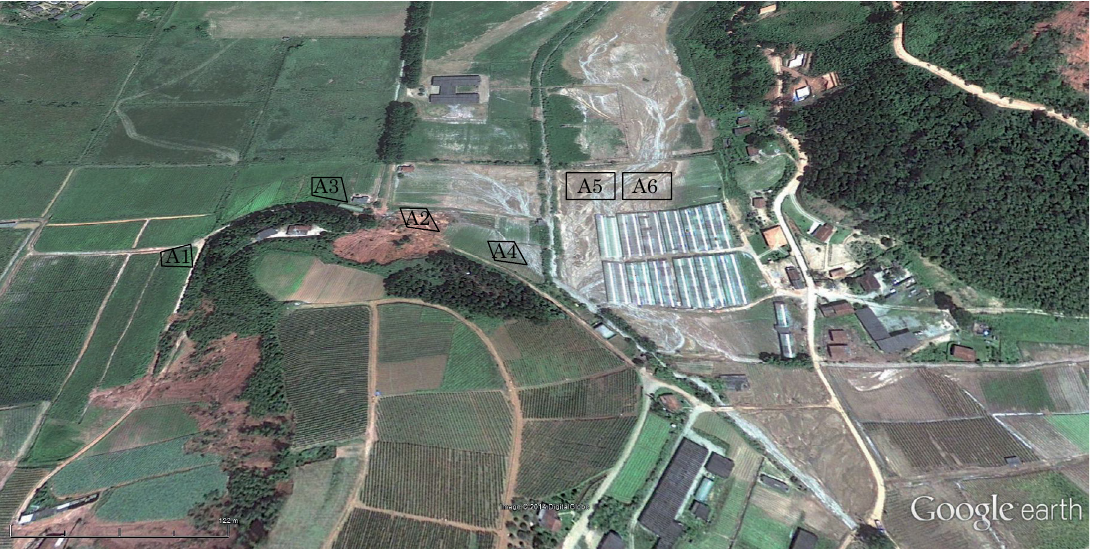
Figura 1. Localização das áreas de estudo na Comunidade Fazenda Rio Grande, Nova Friburgo, RJ. Fonte: Google